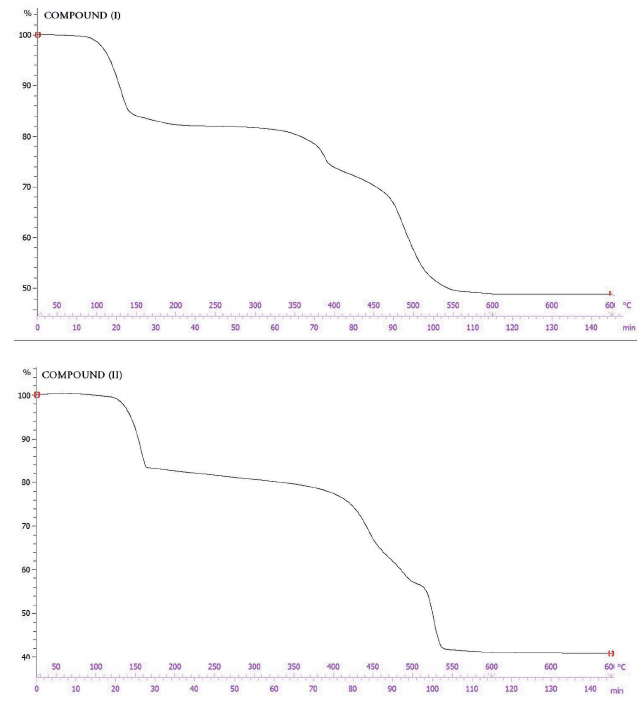
Figure 6 Thermogravimetric analysis of compounds (I) and